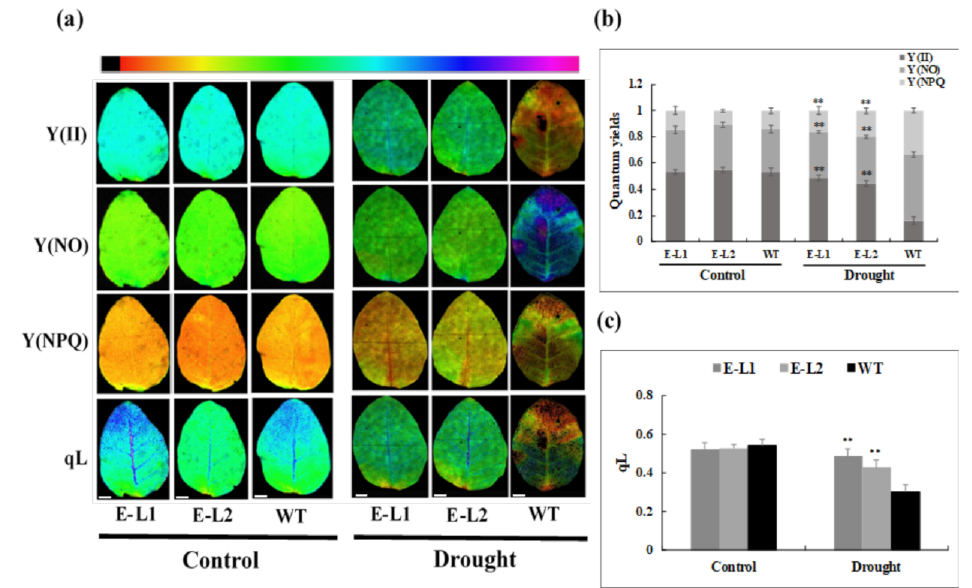
Figure 11. Chlorophyll fluorescence parameters in TgERF1 transgenic and WT plants under water- deficit treatment (Drought) and under well-watered conditions (Control). Plants were grown in individual pots, watered with one-fifth-strength Hoagland solution, and weighed daily during the experiment. Well-watered control plants were grown in 100% field capacity (0% of water loss). The time course drought stress assay started by withholding the nutrient solution until reaching 70% water loss. ( a ) Chlorophyll fluorescence images of Y(II), Y(NO), and Y(NPQ) are shown. The color scale at the top represents absolute values ratio ranging from 0 (black) to 1.0 (pink). Bar: 1.5 cm ( b ) Quantum yield of PSII, including Y(II) (actual photosynthetic efficiency of PS II), Y(NO) (quantum yield of non-regulated energy dissipation), and Y(NPQ) (effective quantum yield of PS II). ( c ) Changes in qL (photochemical quenching coefficient). Physiological parameters were registered in leaves of transgenic and WT plants under normal and water-deficit conditions. Data are presented as the means ± SEM of four biological replicates. Significant differences were determined by ANOVA followed by Dunnett’s test. ** Significant at p <